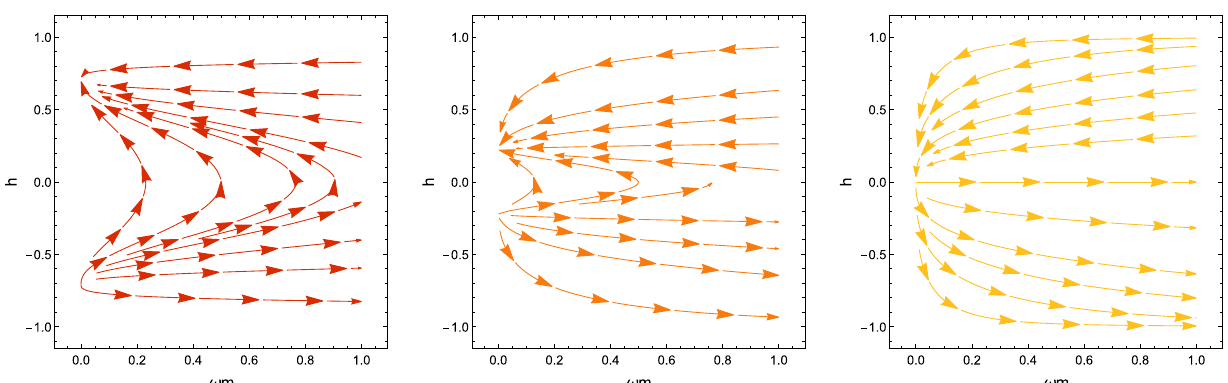
, β = 0 and for three different values of ω m 3